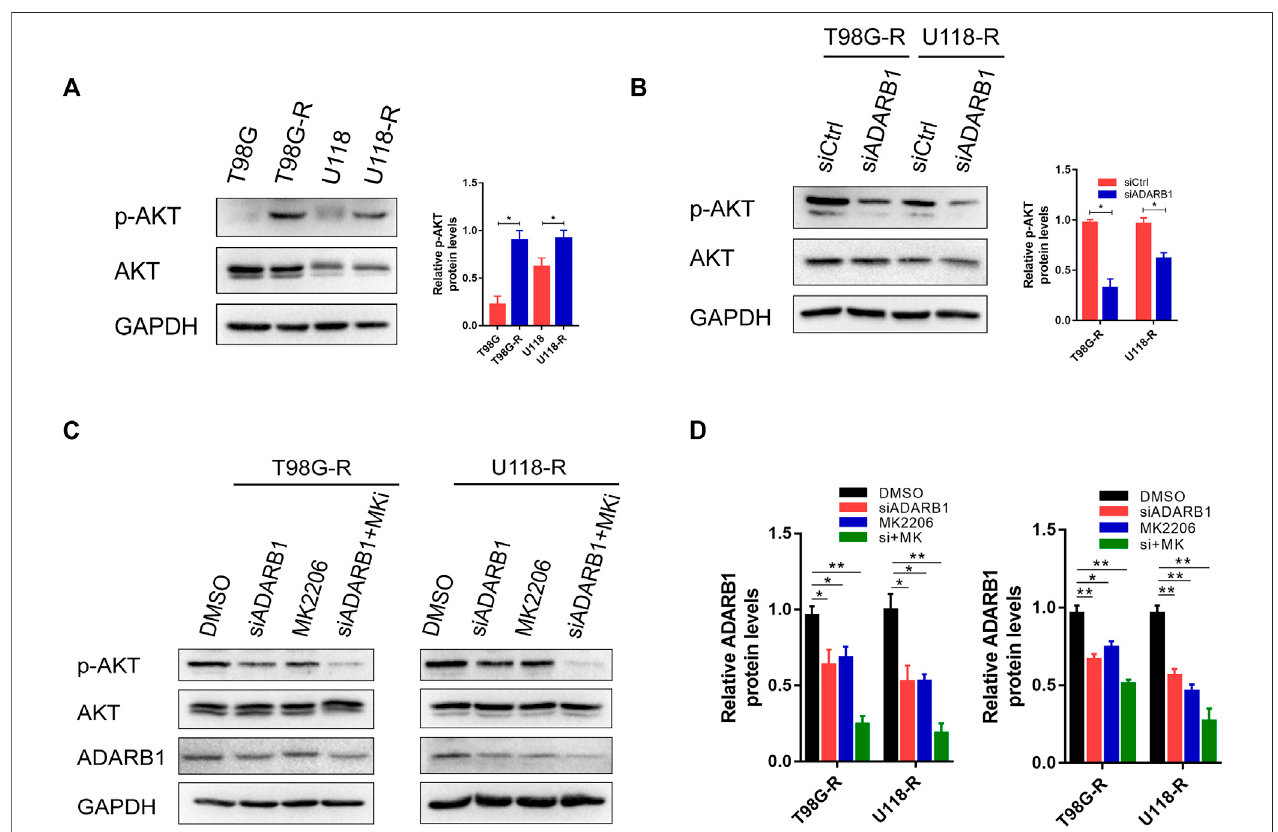
FIGURE 3 | ADARB1 in AKT-mediated TMZ resistance of glioma cells. (A) Western blot for phospho-AKT (Ser-473) and AKT expression in T98G-R and U118-R cells. (B) Western blot for phospho-AKT (Ser-473) and AKT expression in T98G-R and U118-R cells treated with siCtrl or siADARB1. (C,D) Western blot for phospho- AKT (Ser-473), AKT, and ADARB1 in T98G-R and U118-R cells treated with DMSO, siADARB1, MK2206 and co-treated with siADARB1 and MK2206. (E,F) T98G-R and U118-R cells transfected with DMSO, siADARB1, MK2206 and co-treated with siADARB1 and MK2206 were subjected to MTS assays. (G) T98G-R and U118-R cells transfected with DMSO, siADARB1, MK2206 and co-treated with siADARB1 and MK2206 were subjected to colony formation